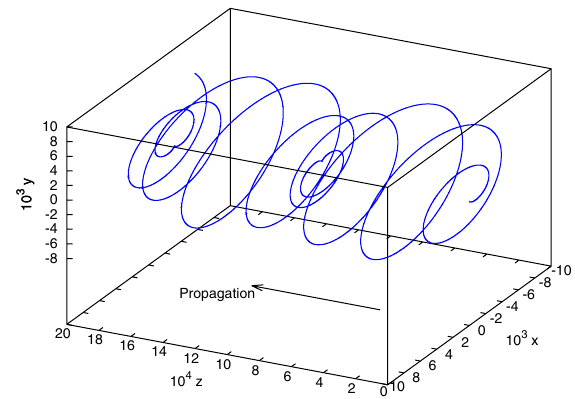
FIG. 10. Particle trajectory under the influence of applied magnetic field of magnitude 0.3. The particle is propagating along the z direction.